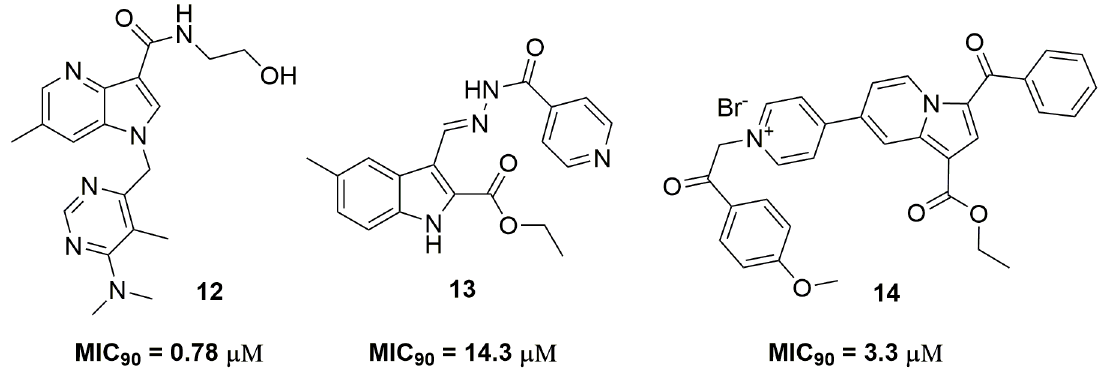
Figure 4. Nitrogen-containing fused heterocycles with potent activity against multidrug-resistant tuberculosis (MDR-TB).